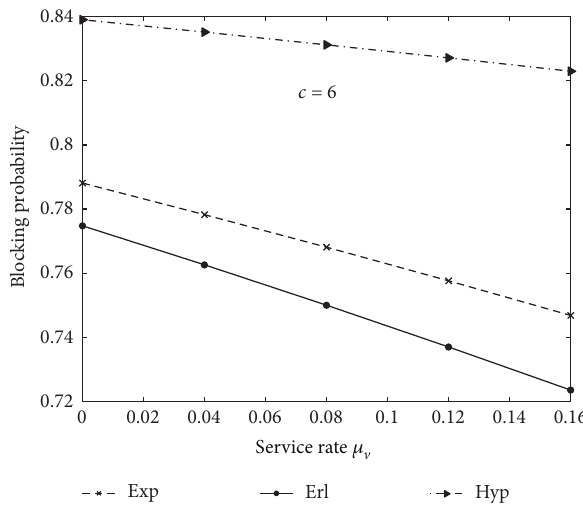
Figure 15: Blocking probability versus vacation-service rate with 𝜌 = 0.9 , 𝜃 = 1 , 𝜉 = 1 , and 𝑐 = 6 .